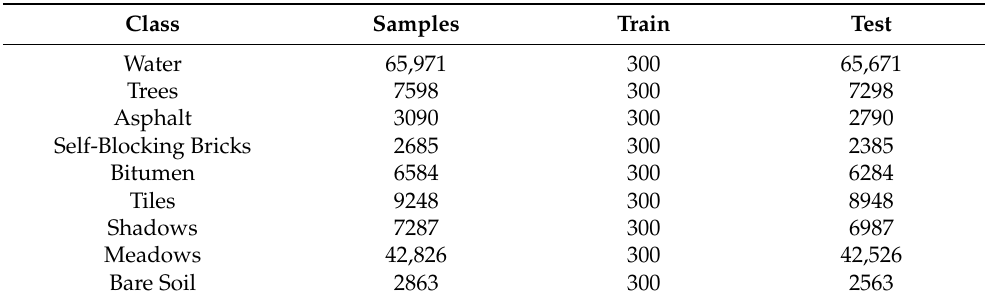
Table 3. Ground truth classes for the Pavia Center scene and their respective numbers of